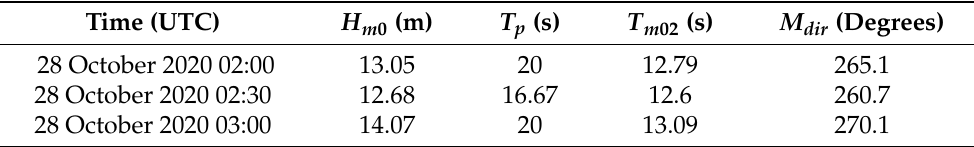
Table 2. Spectral parameters recorded by the M6 Datawell sensor prior to and after the rogue wave measurement: significant wave height ( H m 0 ), peak period ( T p ), mean zero-crossing period ( T m 02 ) and mean spectral wave direction ( M dir